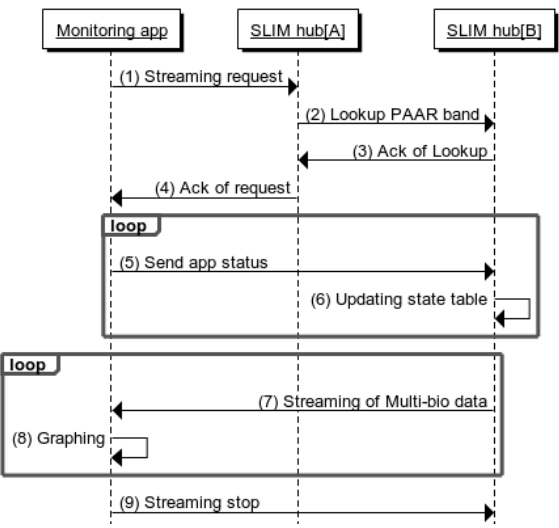
Figure 12. Sequence diagram of streaming service between mobile app and SLIM hub.